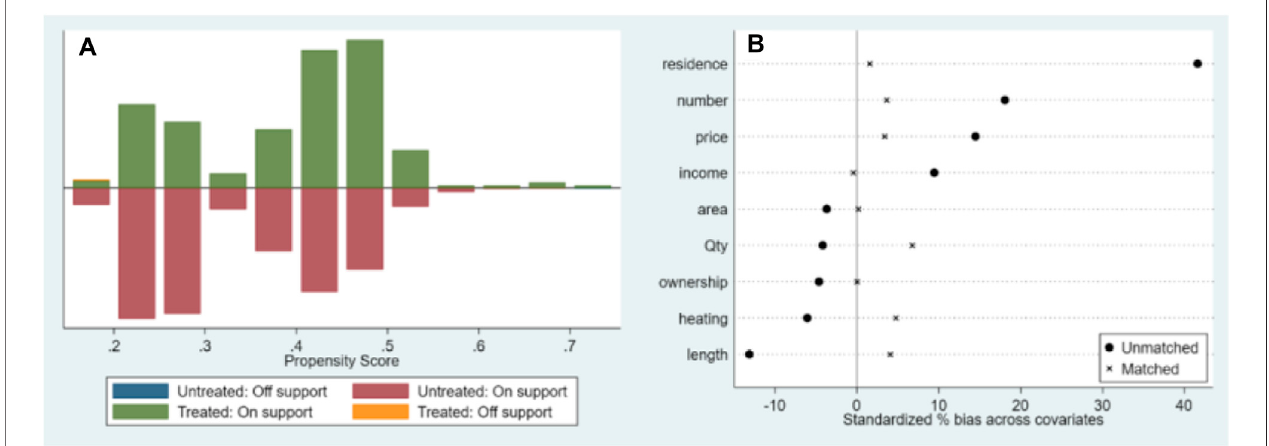
FIGURE 2 | Matching quality and balancing tests of electricity bills. (A) Distribution of propensity score; (B) Standard bias across covariates after matching.